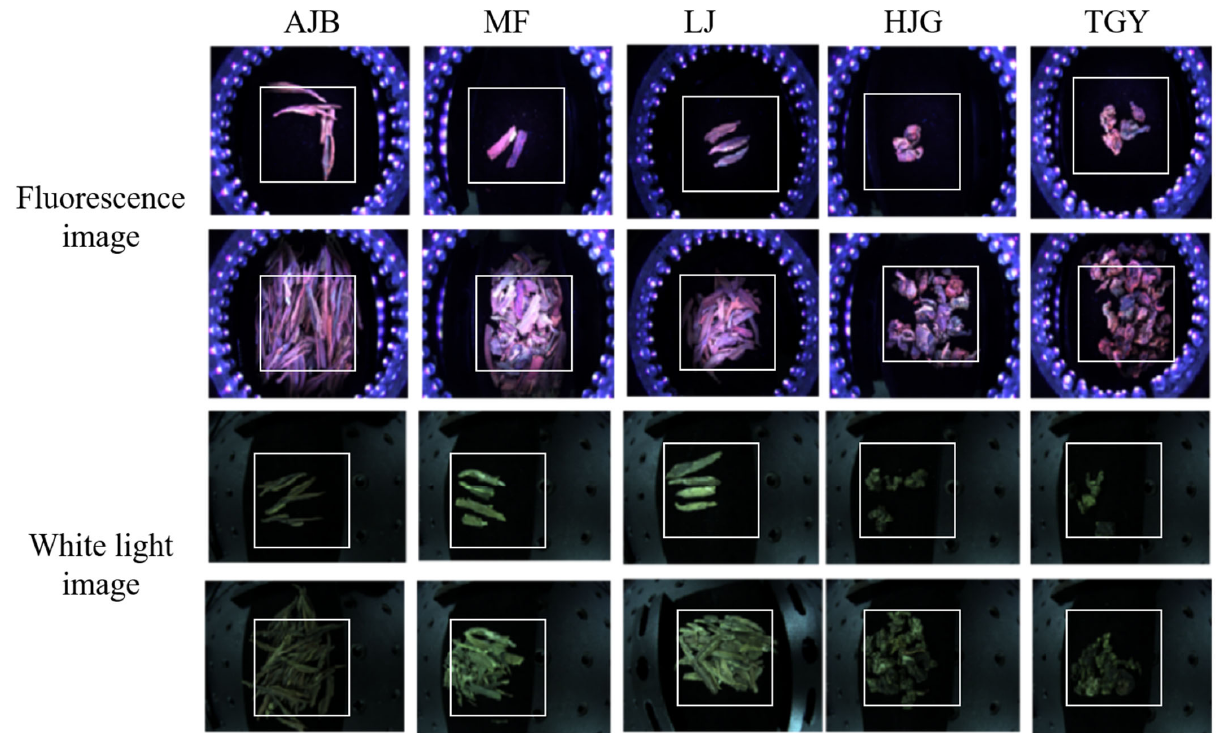
Figure 2. Fluorescence images and white ‐ light images of five different kinds of tea. The ROIs are squared in white boxes. AJB, MF, LJ, HJG, and TGY stand for the Anjibai tea, Maofeng tea, West Lake Longjing tea, Huangjingui tea, and Tieguanyin tea, respectively.